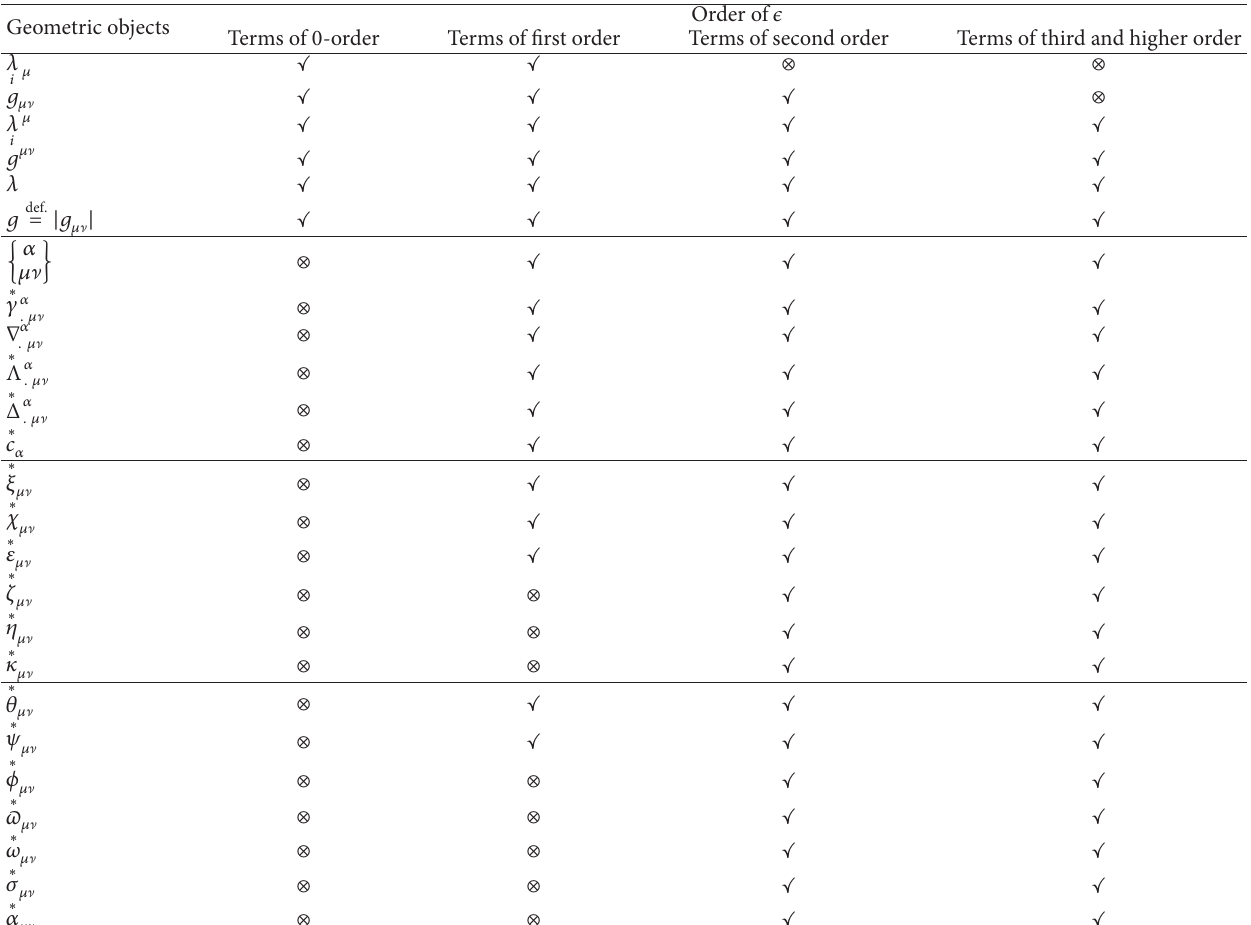
Table 2: Expansion of the geometric